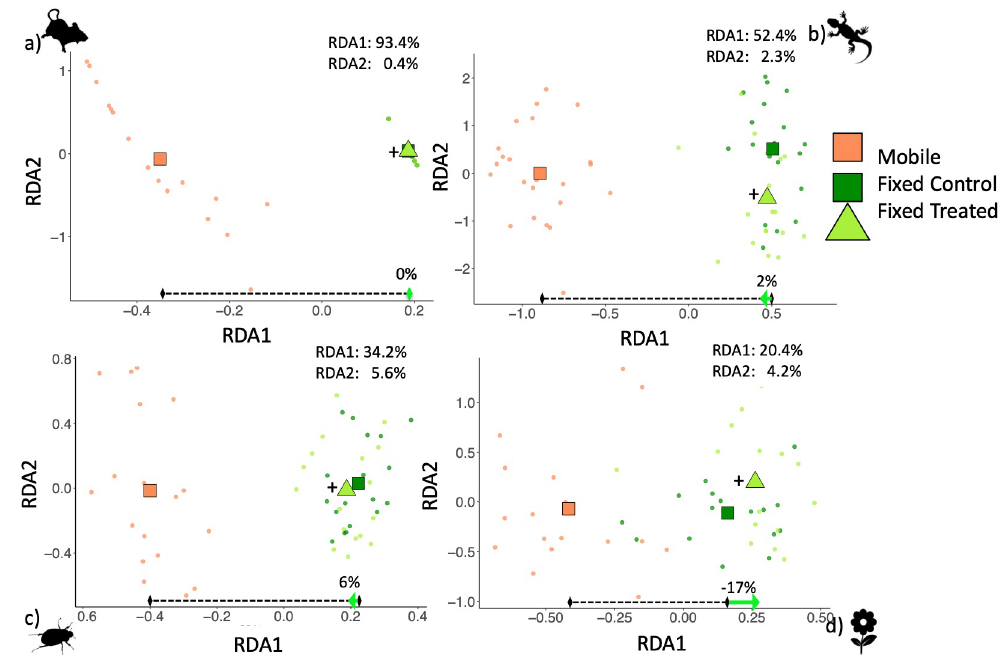
Figure 6. Redundancy analysis for ( a ) rodents, ( b ) reptiles, ( c ) beetles and ( d ) annual plants in treated fixed dunes compared to untreated fixed (control) and mobile dunes (reference). Distance bars along the 1st RDA axis show the treatment e ff ect (green arrow) as a percentage of total distance between control and reference (black dashed). Significant di ff erences were tested using pairwise Permanova. * and + represent p < 0.05 for treated dunes compared to control and reference dunes,